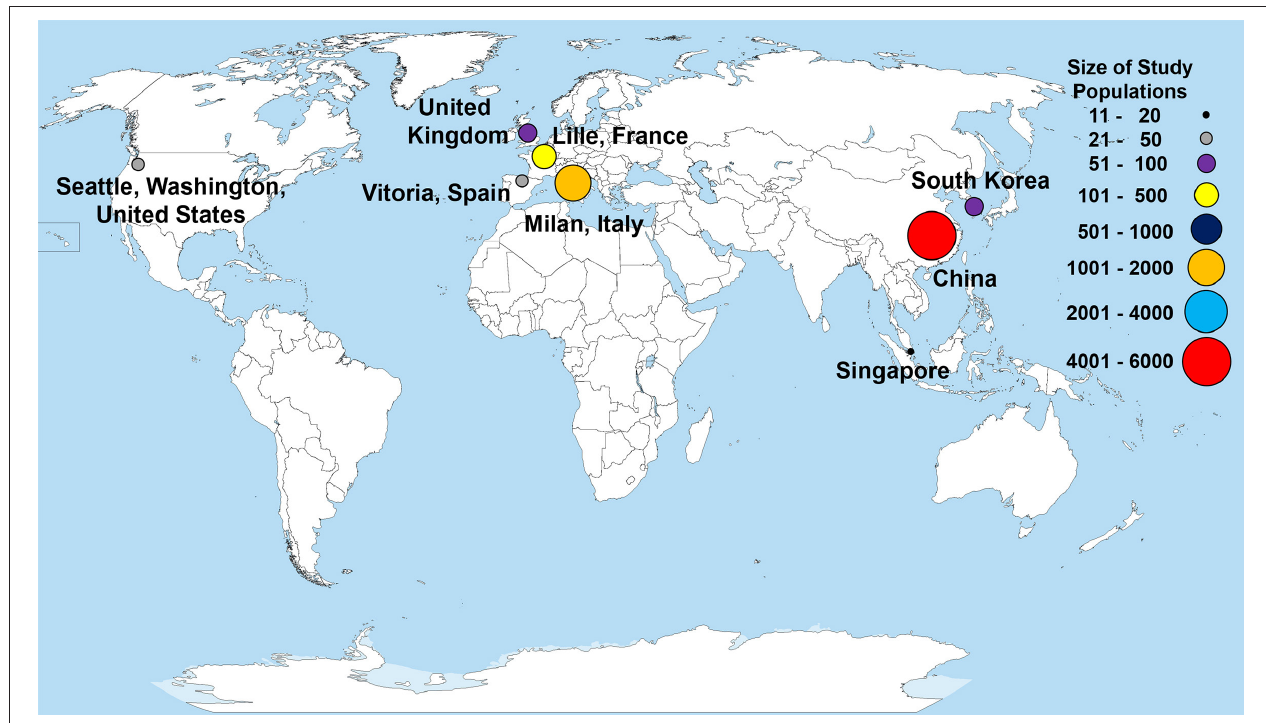
FIGURE 2 | Countries and locations for the selected studies used in the meta-analysis. Total patient populations in each of the study locations are illustrated with a colored circle and correspond to the size of study populations. Each point represents a research study, except for China, which represents the total patient population from 24 different studies. The world map was obtained from Wikimedia Commons, the free media repository licensed under the Creative Commons Attribution-Share Alike 3.0 Unported license.